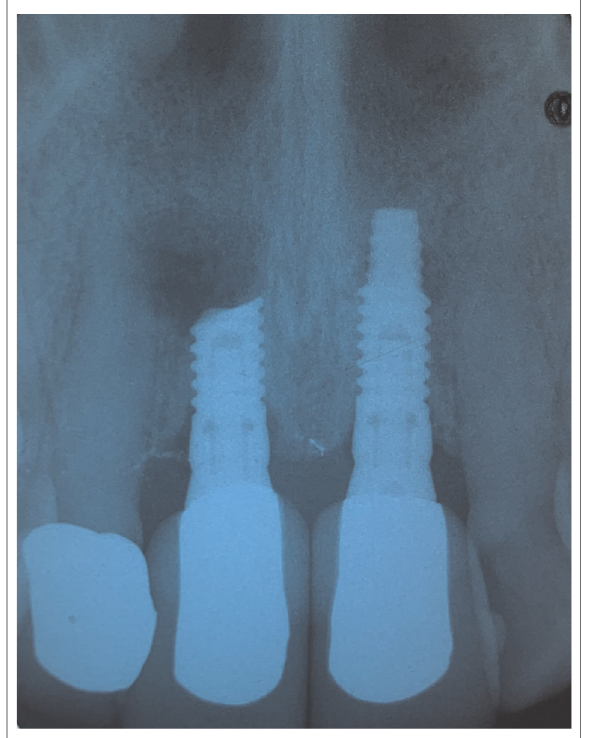
FIGURE 4 Radiograph at 2 years post-apicoectomy. Full bone remodeling